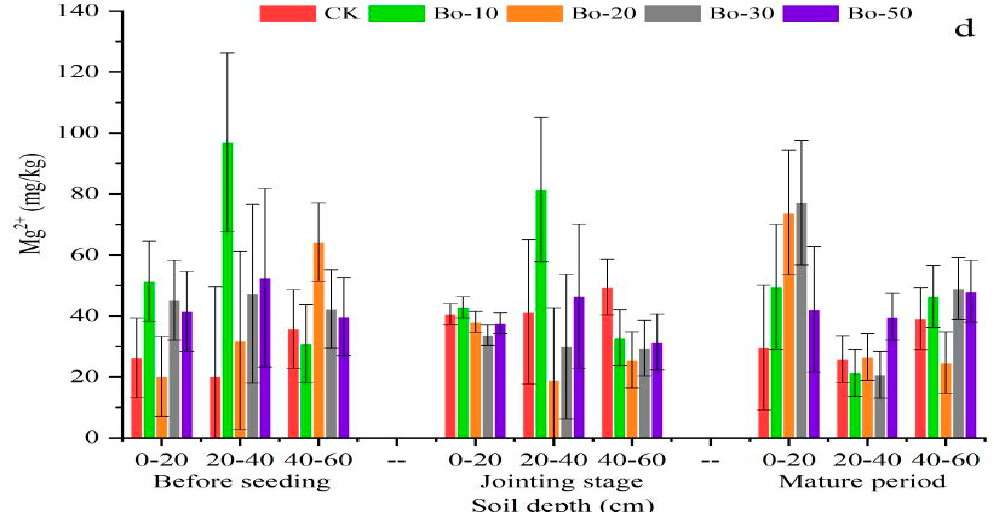
Figure 6. Effect of biochar on soil ions (( a ) Na, ( b ) K, ( c ) Ca, ( d ) Mg) exchange capacity in three soil depths over growth stages. Data are presented in the average with standard error bars ( n = 3) (CK: control experiment; Bo-10, Bo-20, Bo-30, and Bo-50: biochar applications of 1.0 kg/m 2 , 2.0 kg/m 2 , 3.0 kg/m 2 , and 5.0 kg/m 2 ,respectively).